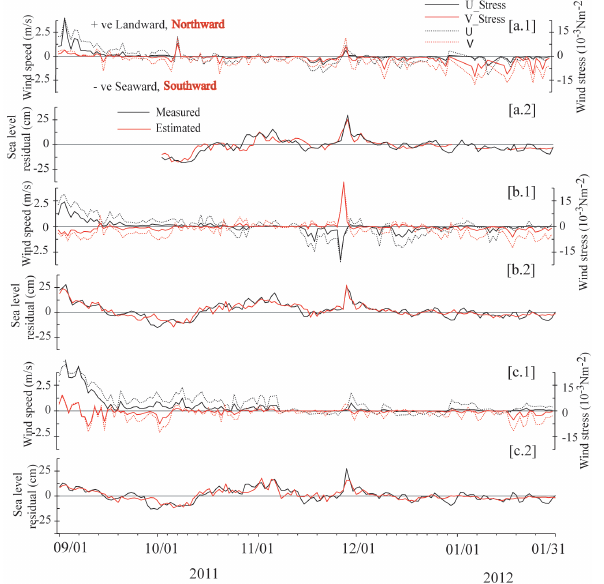
Figure 6. Daily mean wind, wind stress, measured sea level resid- ual and estimated sea level residual from September 2011 to Jan- uary 2012 at (a) Ratnagiri, (a.1) daily averaged cross-shore (black) and along-shore (red) winds stress along with respective winds (dot- ted black or red), (a.2) daily mean measured sea level residual (black) and estimated residual (red); (b) Verem, (b.1) and (b.2) same as in (a) ; (c) Karwar, (c.1) and (c.2) same as in (a) . Daily mean es- timated SLR is obtained using the multi-linear regression method using daily mean cross-shore ( τ U ) , along-shore ( τ V ) components of winds stress and atmospheric pressure ( A P ) as independent vari- ables.